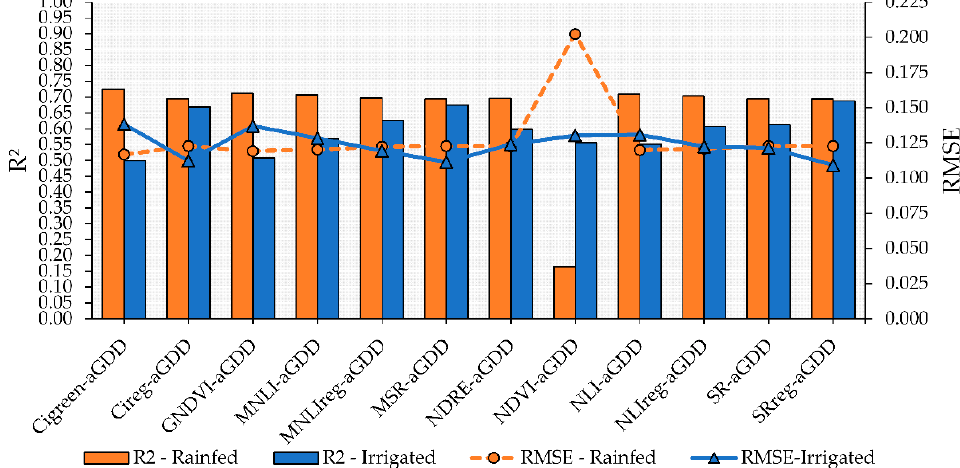
Figure 5. Performance of multiple linear regression combining vegetation indices (VIs) and adjusted growing degrees days (aGDD) to predict peanut pod maturity in irrigated and rainfed areas. Blue bars and solid blue line with triangle symbol indicate the R 2 and RMSE, respectively, for the irrigated area. Orange bars and dashed orange line with circle symbol indicate the R 2 and RMSE, respectively, for the rainfed area.